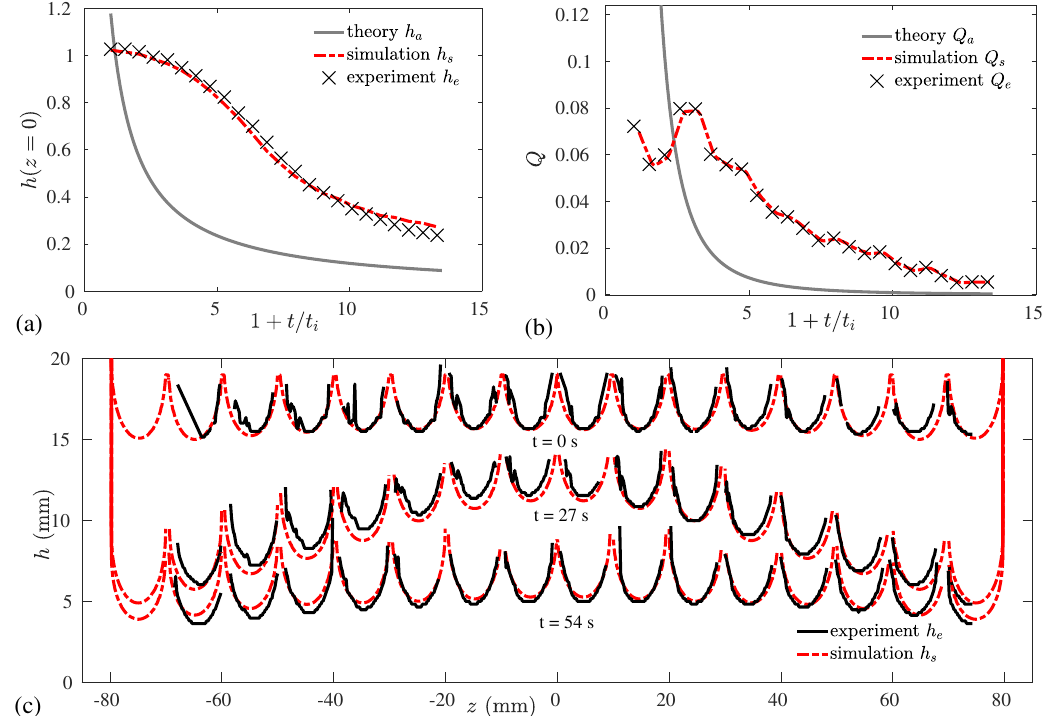
Figure 13. ( a ) h s (dashed), h a (8) (solid), and h e (ticks) and ( b ) Q s (dashed), Q a (10) (solid), and Q e (ticks) with time. ( c ) Dimensional h s (dashed) against h e (solid) at specified